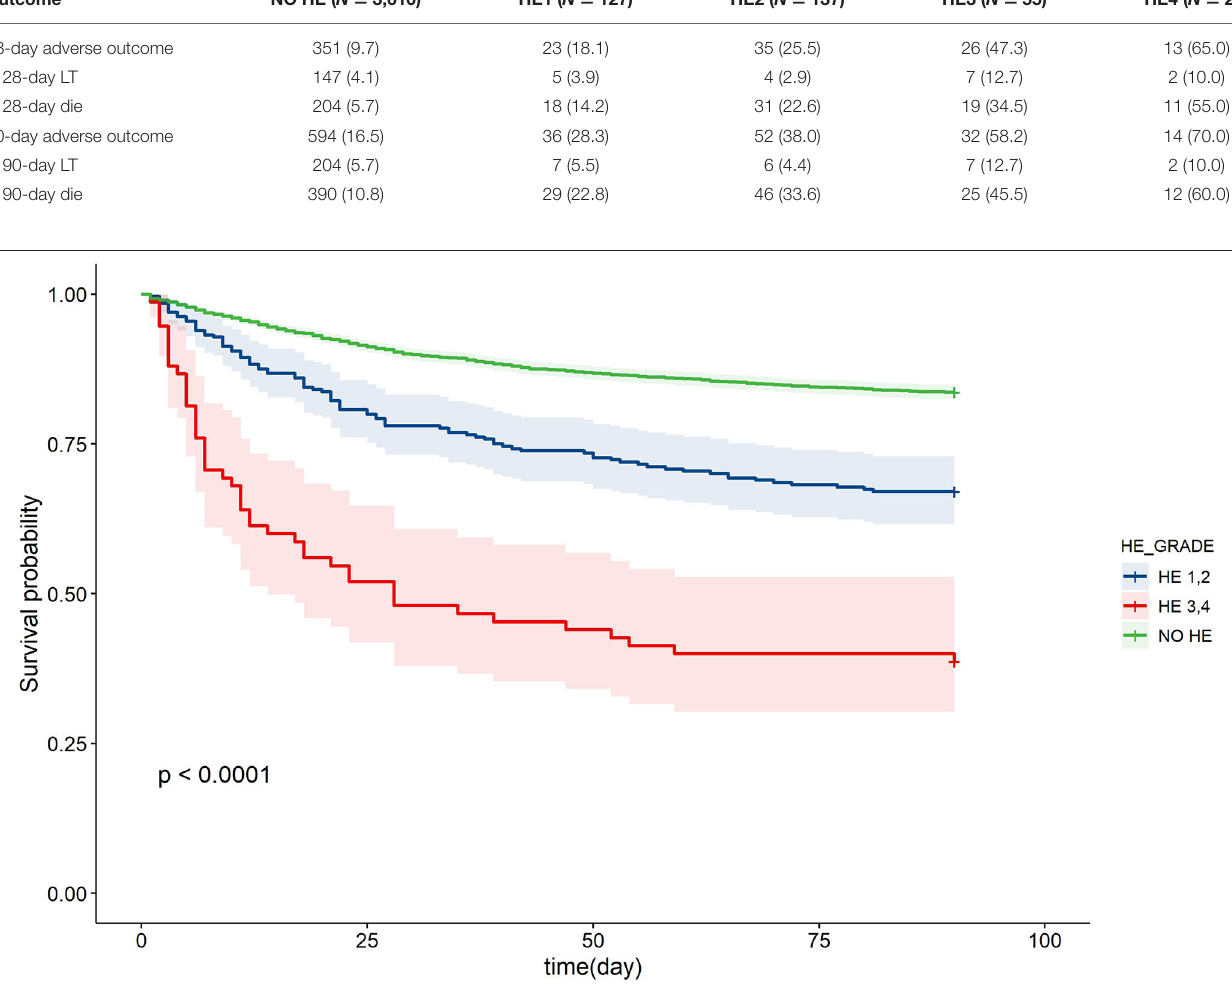
FIGURE 2 | Kaplan-Meier curve of patients with chronic liver disease and acute events in different HE grades. HE, hepatic